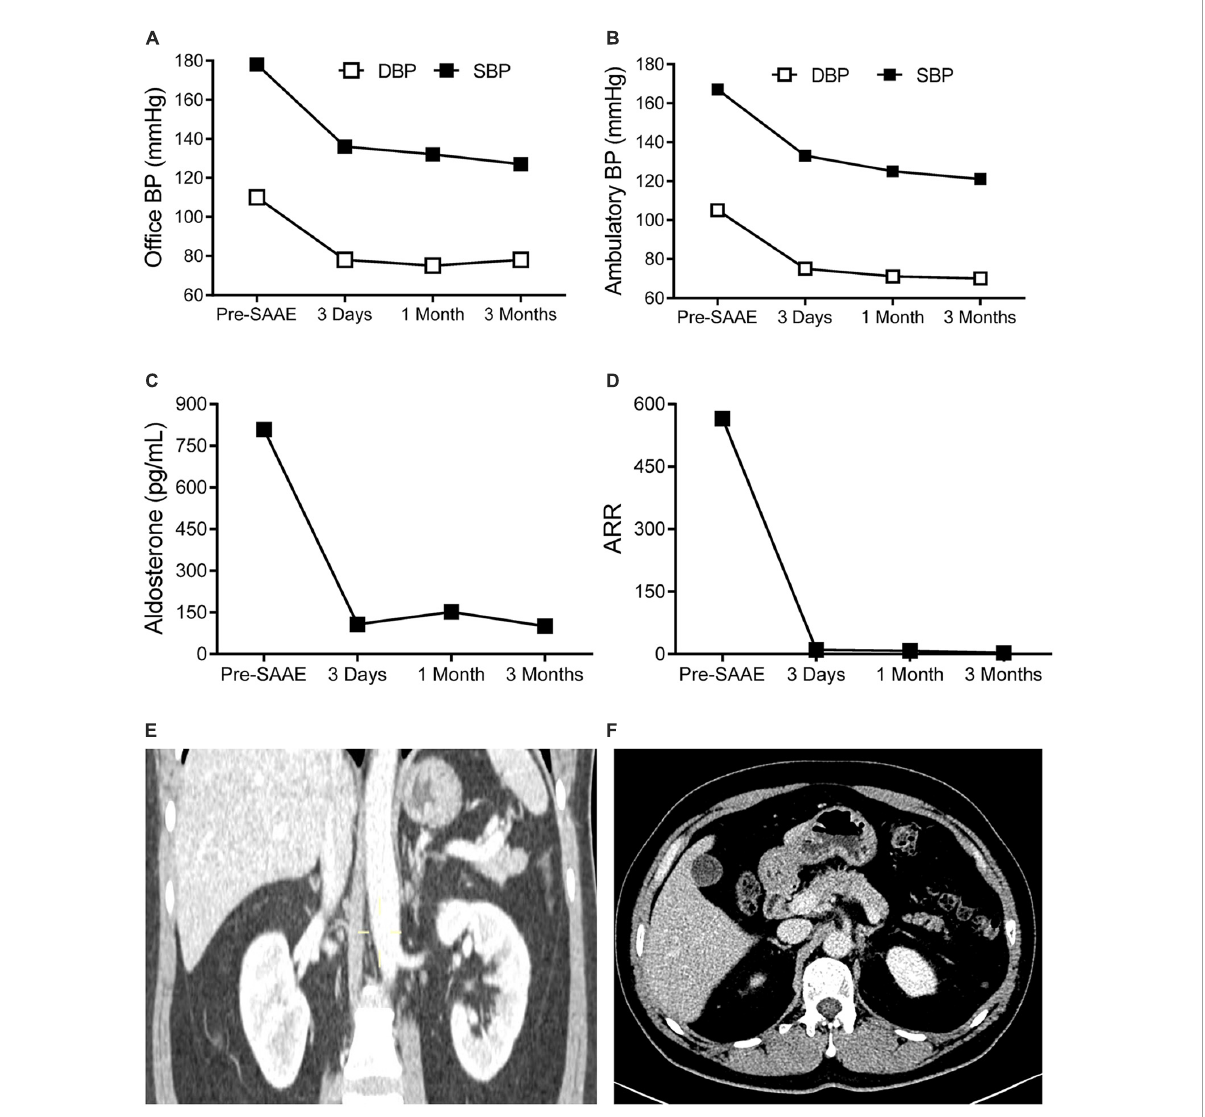
FIGURE3 The effects of superselective adrenal arterial embolization (SAAE). Office (A) and mean ambulatory blood pressure (BP) (B) , plasma aldosterone levels (C) , and aldosterone to renin ratios (ARR) (D) of the patient before SAAE and 3 days, 1 month, and 3 months after SAAE. Contrast-enhanced computerized tomography showing disappearance of the left adrenal adenoma. (E) Coronal view. (F) Cross-sectional view. Abbreviations: DBP, diastolic blood pressure; SBP, systolic blood